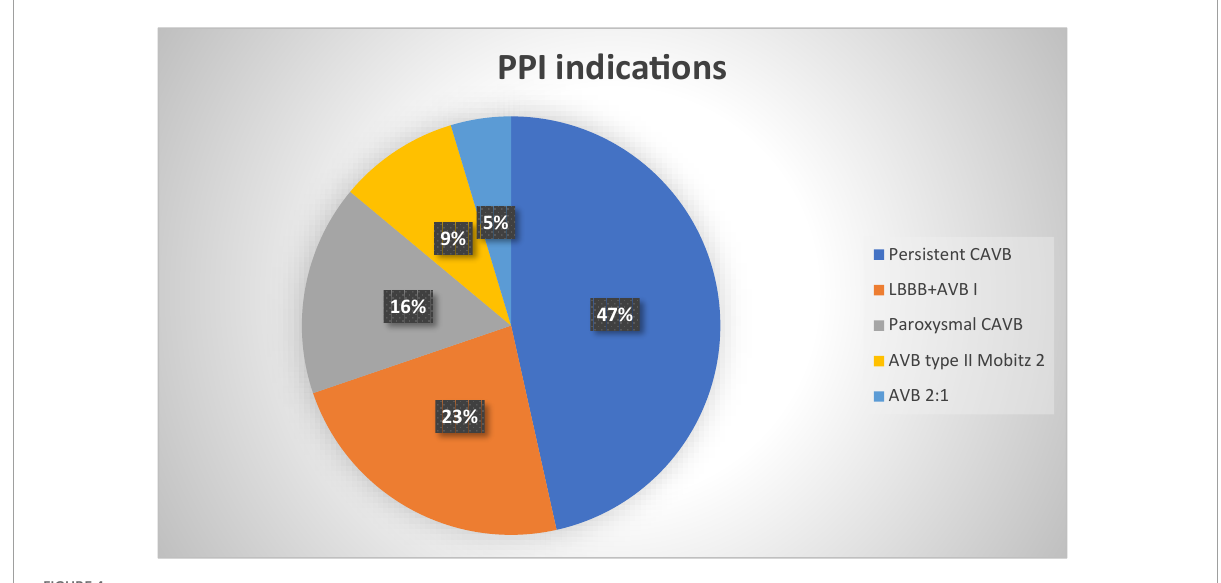
FIGURE4 Permanent pacemaker indications percentages. PPI, permanent pacemaker implantation; CAVB, complete atrioventricular block; LBBB, left bundle branch block; AVB, atrioventricular block.